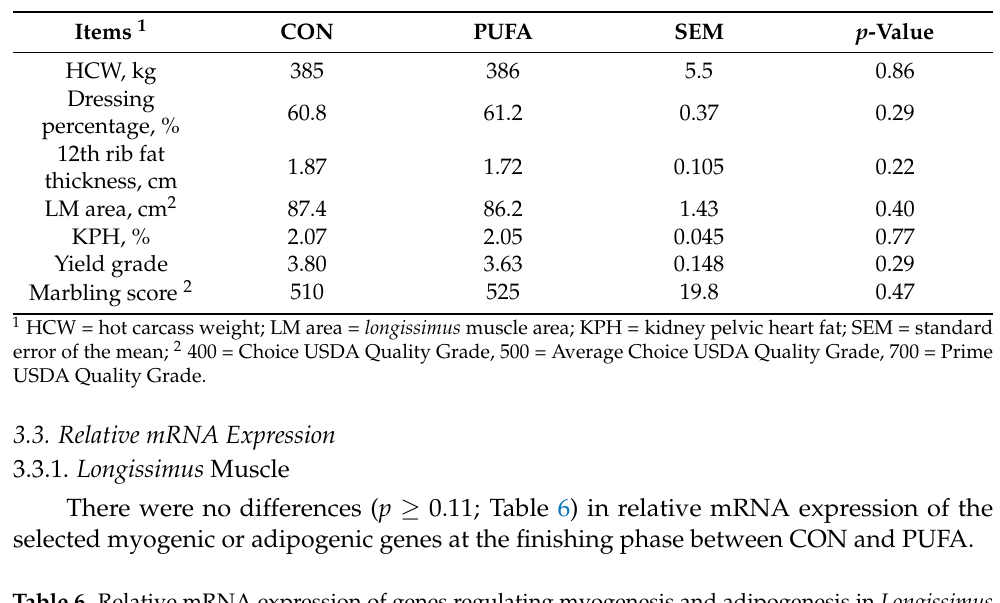
Table 6. Relative mRNA expression of genes regulating myogenesis and adipogenesis in Longissimus muscle of the steer progeny born from cows supplemented with either 155 g DM/d EnerGII (CON) or 80 g DM/d Strata + 80 g DM/d Prequel (PUFA) for the last 77 ± 6 d of gestation 1. Genes